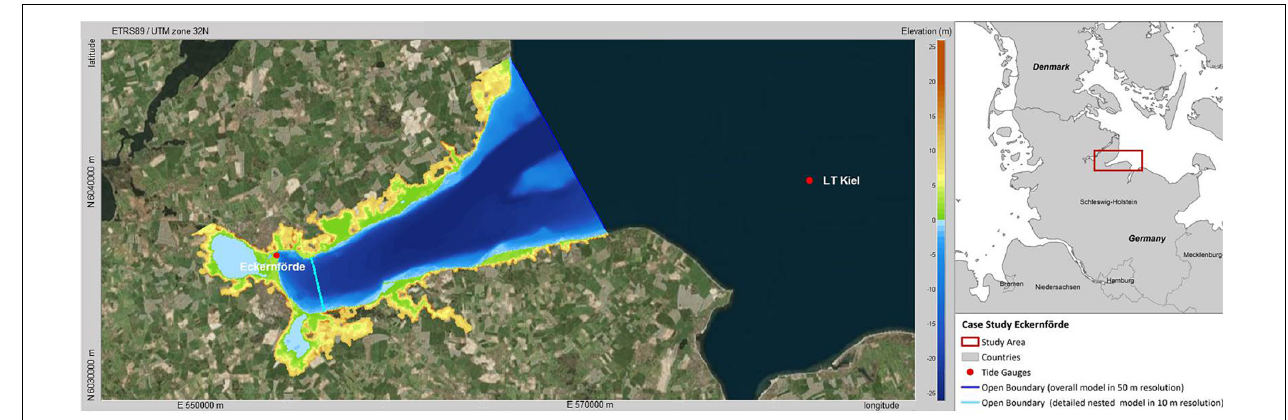
FIGURE 1 | Location of the study area Eckernförde Bay and computational domain of the nested model setup in Delft3D including the tide gauges and the open boundaries of the coarser and the nested model. Bathymetry is displayed in shades of blue and land surface is displayed in green to red colors. The coastal boundary runs along